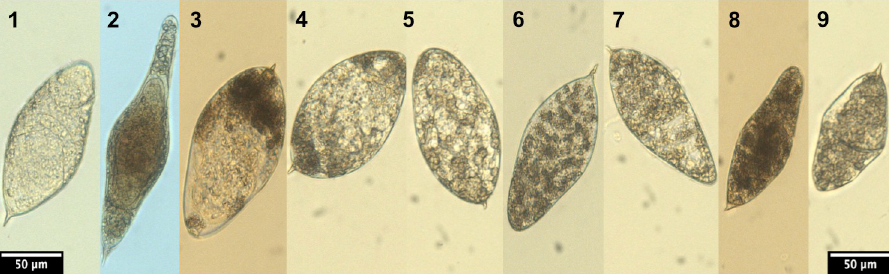
Fig 1. Egg morphologies of the pure parental species and the European S . haematobium-bovis hybrids. Eggs 1 and 2 show typical morphologies of S . haematobium (elliptical with a terminal spine) and S . bovis (spindle shape with a terminal spine), respectively from laboratory isolates. Eggs 3–9 show the egg morphology of the European S . haematobium-bovis hybrid schistosome. While most eggs were of a typical S . haematobium morphotype (3–7), there was a high variability in the morphologies and near 10% (4/44) of eggs were non-typical (8–9).